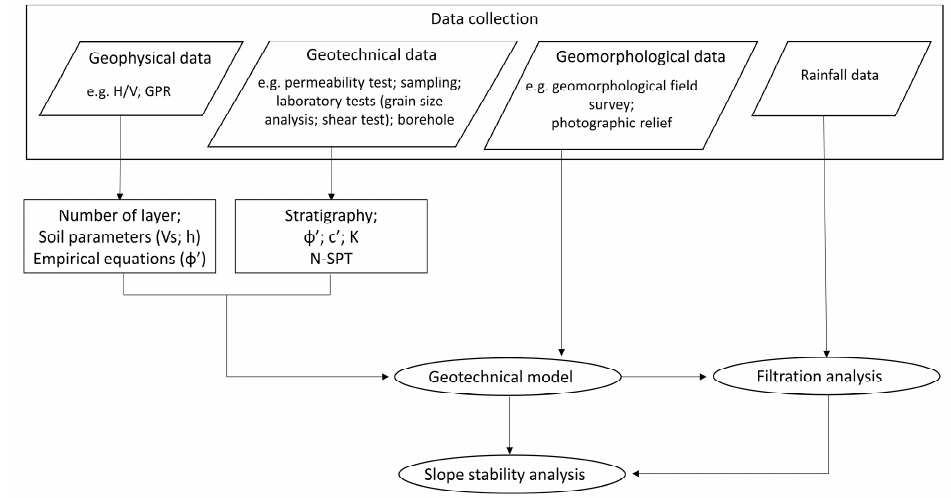
Figure 2. Flowchart of the phases and data needed to reconstruct the geological–geotechnical model of the slope employed in the stability analysis using the GEOSLPE package.